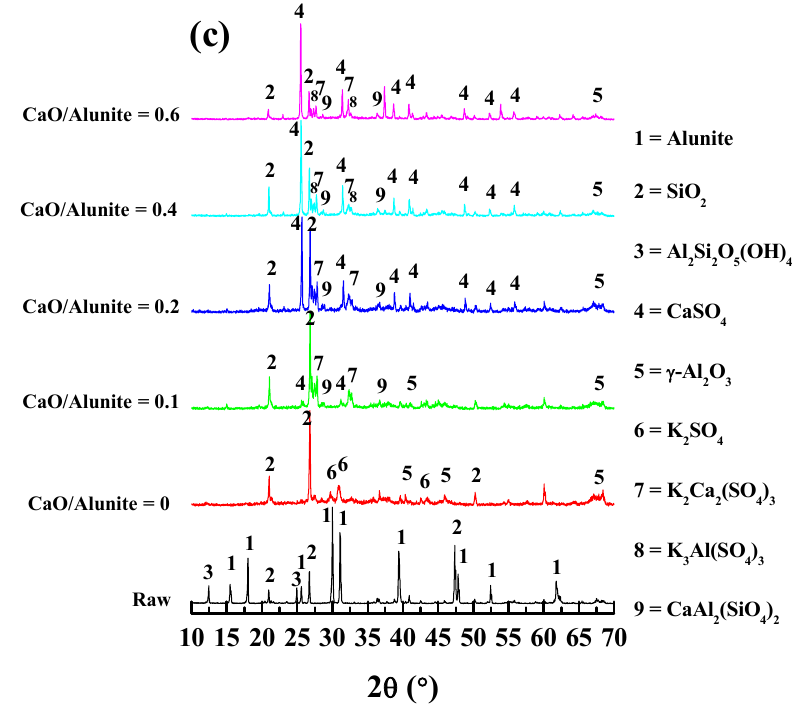
Figure 5. XRD patterns of the alunite–CaO system at different decomposition temperatures: ( a ) 600 °C; ( b ) 700 °C; and ( c ) 800 °C.